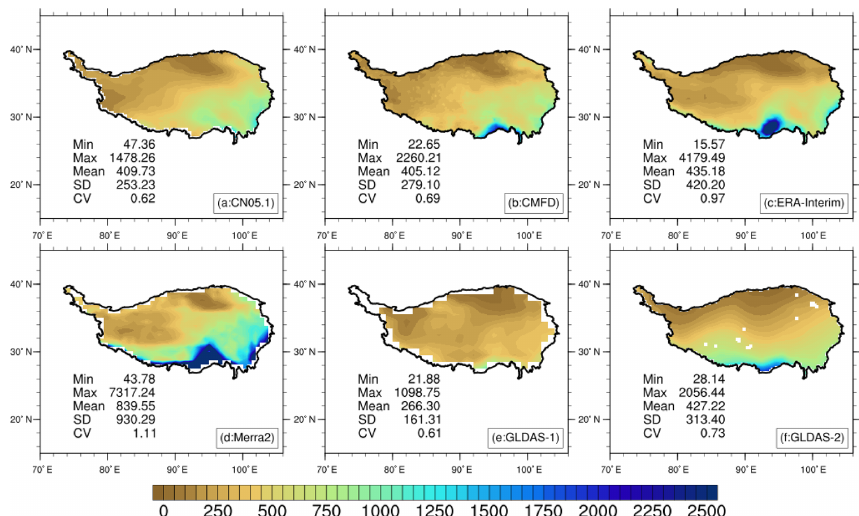
Figure 5. Spatial distribution of mean annual precipitation derived from six forcing datasets for the Tibetan Plateau (1985–2014): (a) CN05.1, (b) CMFD, (c) ERA-Interim, (d) MERRA2, (e) GLDAS version1, and (f) GLDAS version 2. Statistic values, such as minimum (Min), maximum (Max), mean (Mean), standard deviation (SD), and coefficient of variation (CV), are also shown in each plot.